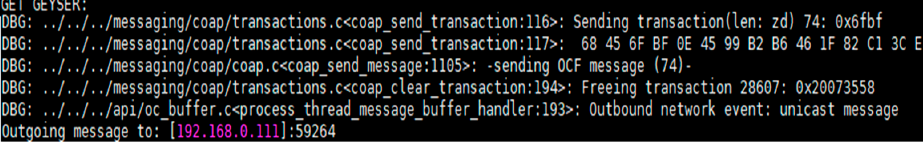
Figure 10. Energy consumption monitoring on IotSmartApp . 4.1.2. Home Automation via Energy App We evaluated the platform’s ability to provide space agnostic on/off control of the home appliances under consideration. In Figure 11, a POST interaction is performed whenever the client request and update an appliance status (On/Off). After updating the state of an appliance from a POST request, the resource server sends a 39 bytes acknowledgment response to the requesting client at 192.168.0.111:8000. Figure 11. HAN server POST response .